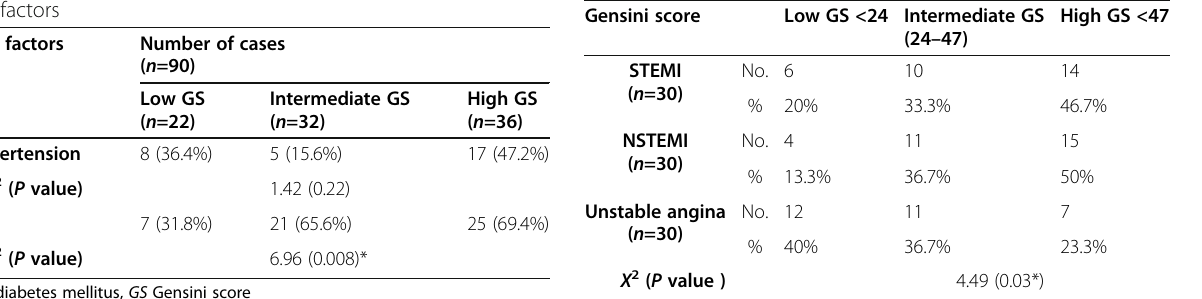
Table 2 Comparison between the studied patients as regard risk factors Risk factors